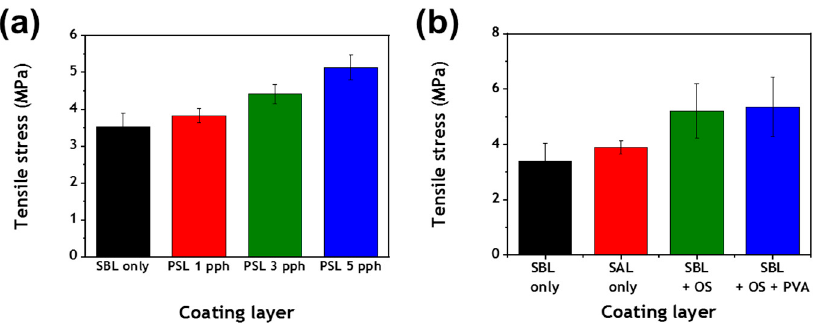
Figure 7. ( a ) Tensile stress of coating layers containing various amounts of the PS latex cobinder and ( b ) the effect of styrene/acrylate (S/A) latex (SAL), oxidized starch (OS), and polyvinyl alcohol (PVA) on the tensile stress of the coating layers.